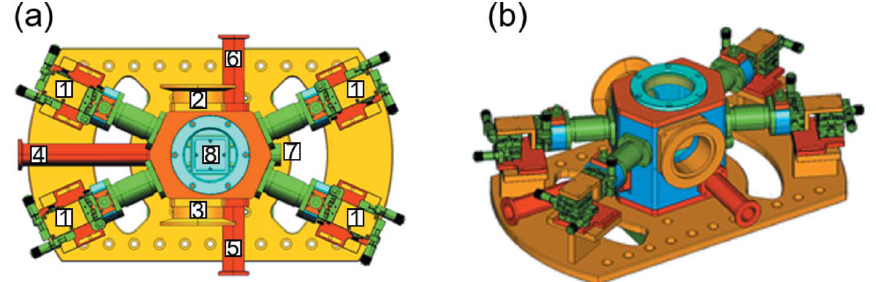
Figure 1 Conceptual design of the miniature X-ray probe station. ( a ) Top view and ( b ) perspective view. It mainly consists of a miniature vacuum chamber and motion stages for the probe